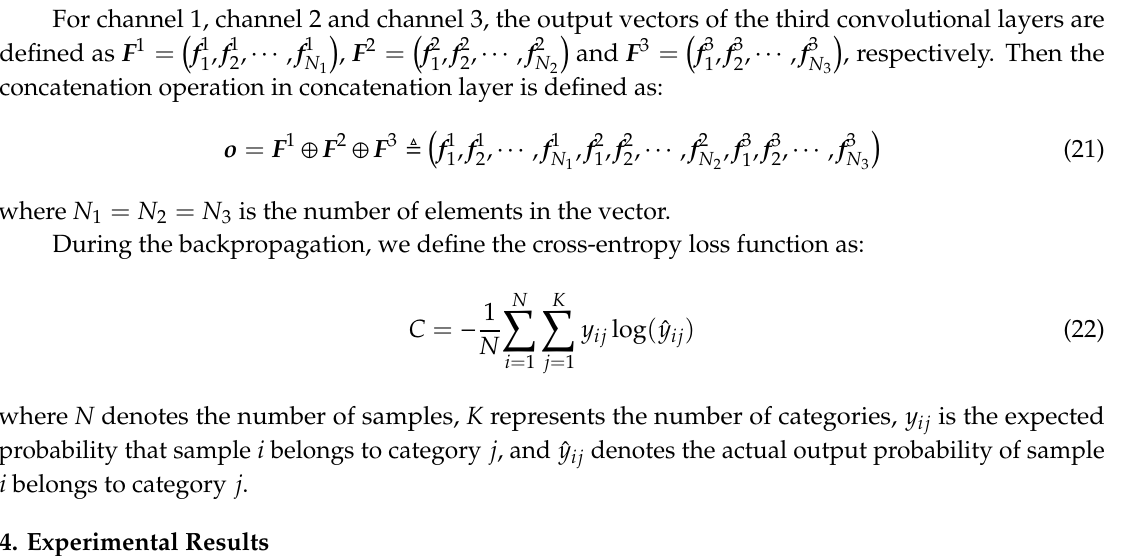
Figure 5. Structure of multi-channel three-dimensional convolution neural network (MC-3DCNN).